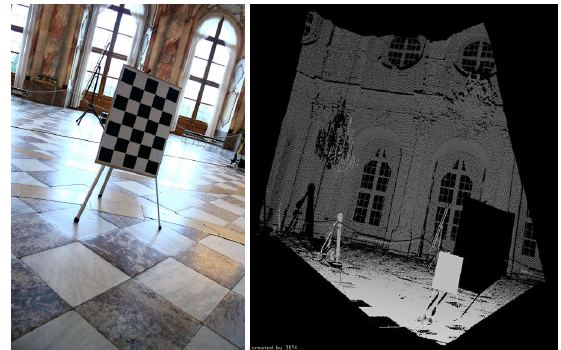
Figure 3: The calibration board seen from Irma3D in the W¨urzburg Residence as photo (left) and point cloud